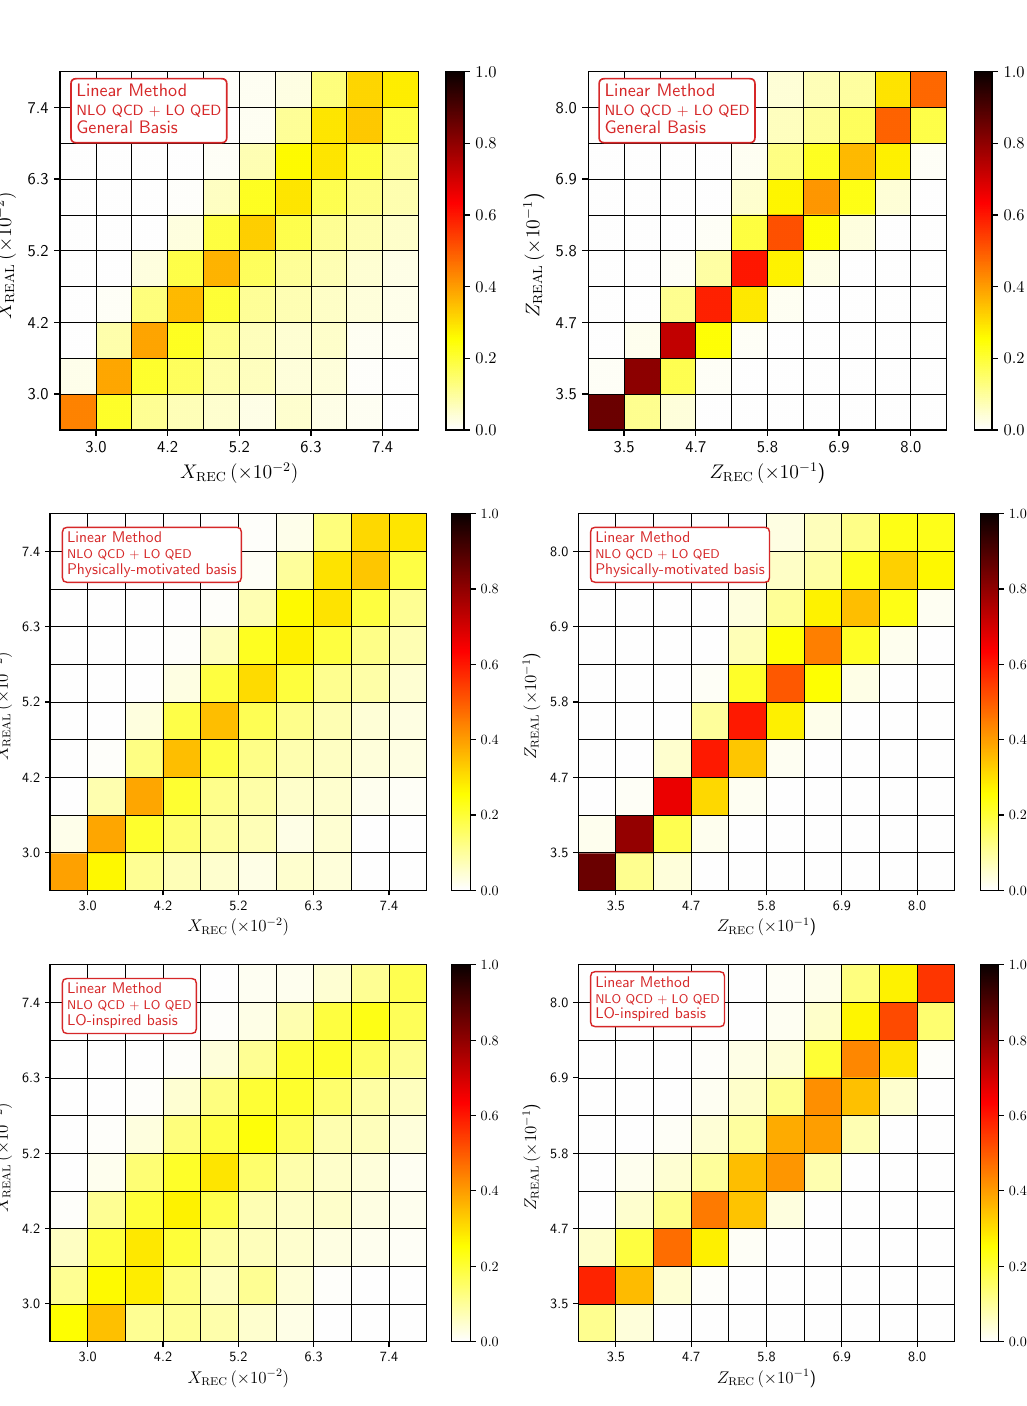
and Z ) REAL REAL REC